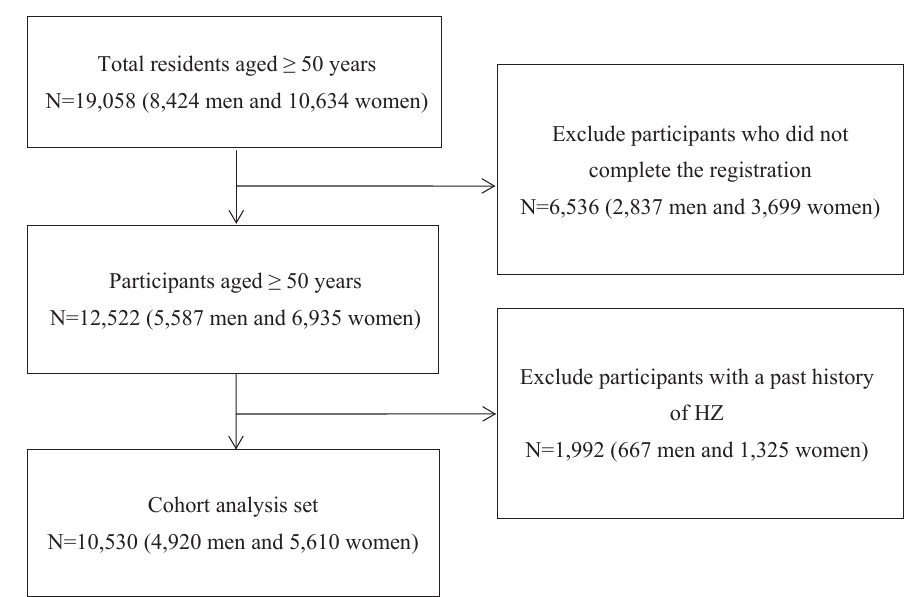
Fig. 1 Flow chart of the selection for study